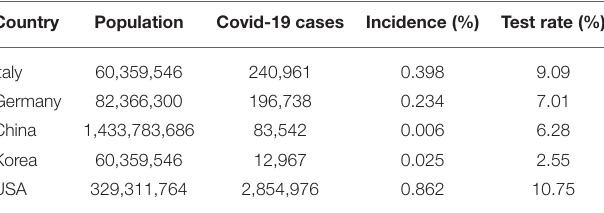
TABLE 2 | RG value by country. Country RG